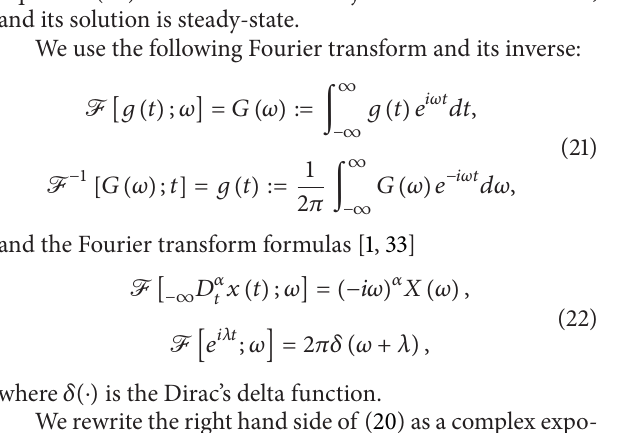
Figure 2: Solid line: 𝑌(𝑡) versus 𝑡 on interval 0 ≤ 𝑡 ≤ 15 for 𝑐 = 1, 𝜆 = 1 , and 𝛼 = 1.5 ; dashed line: 𝑡 sin (𝑡)/2 versus 𝑡